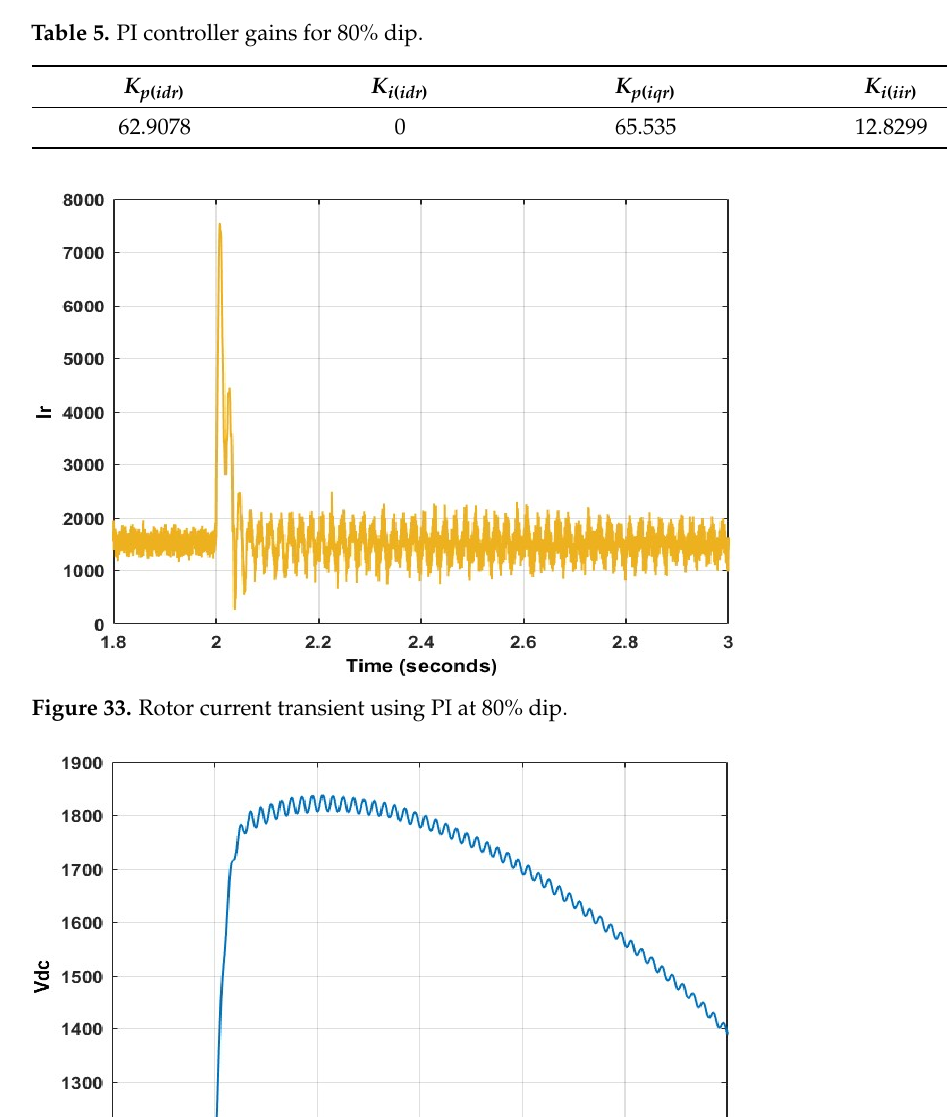
Figure 35. Rotor direct axis current ripple using PI at 80% dip.